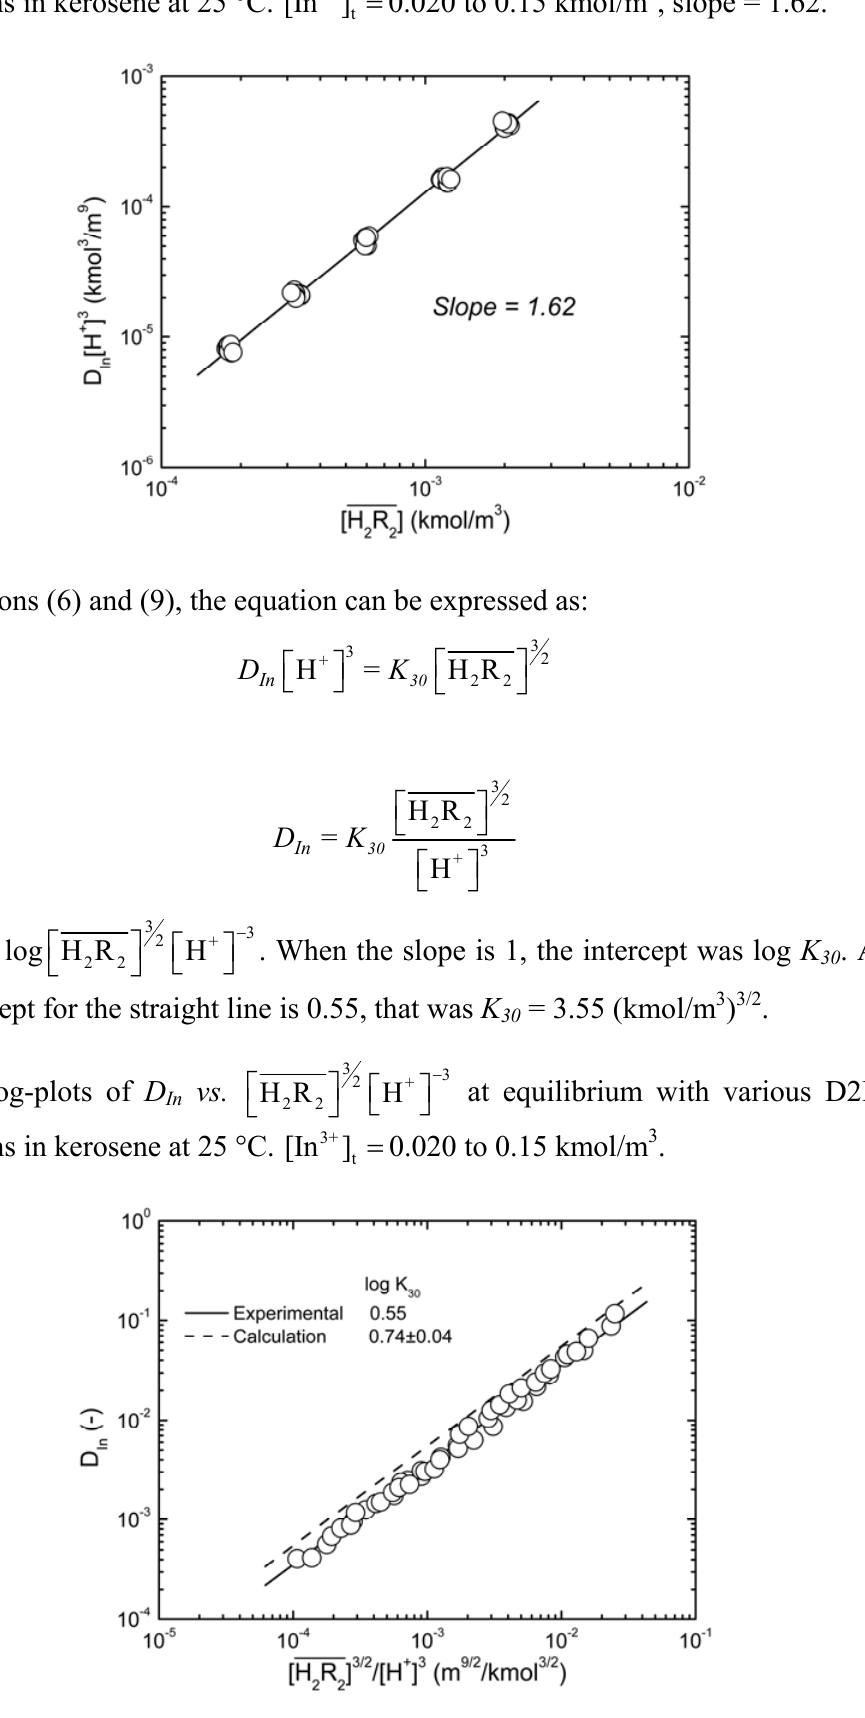
3 + H   vs. at equilibrium with various D2EHPA H R   In     2 2